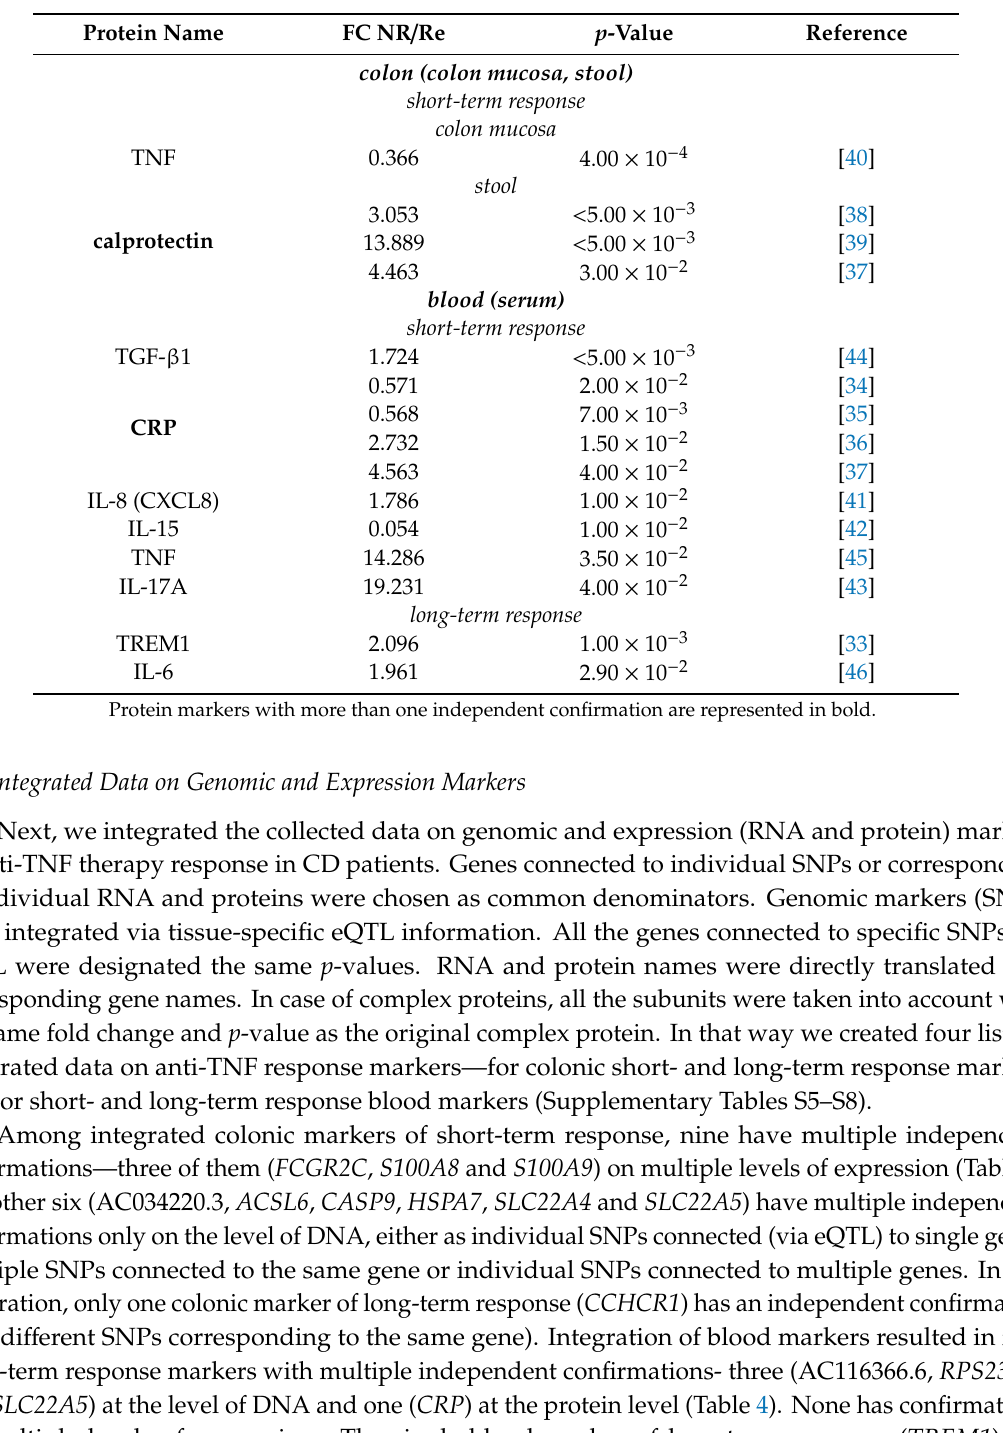
Table 3. Protein markers linked to anti-TNF response in CD patients